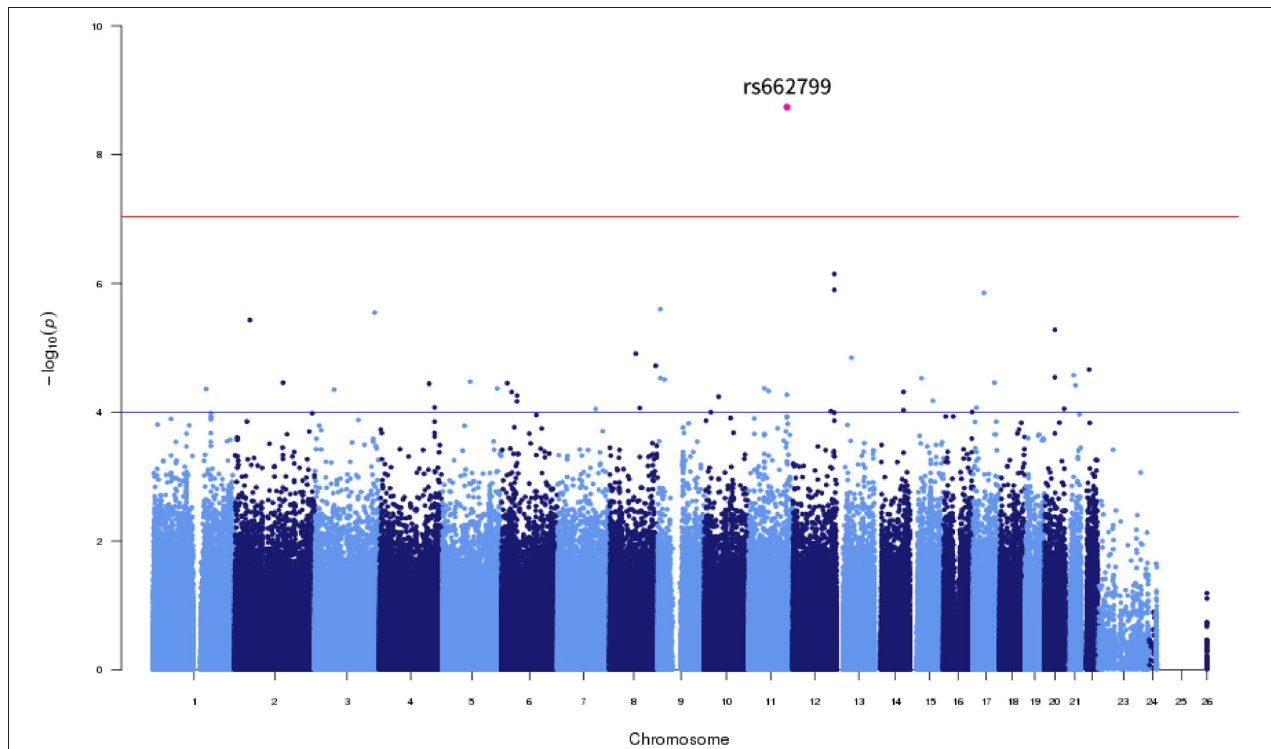
FIGURE 1 | Manhattan Plot for LDL cholesterol variability by